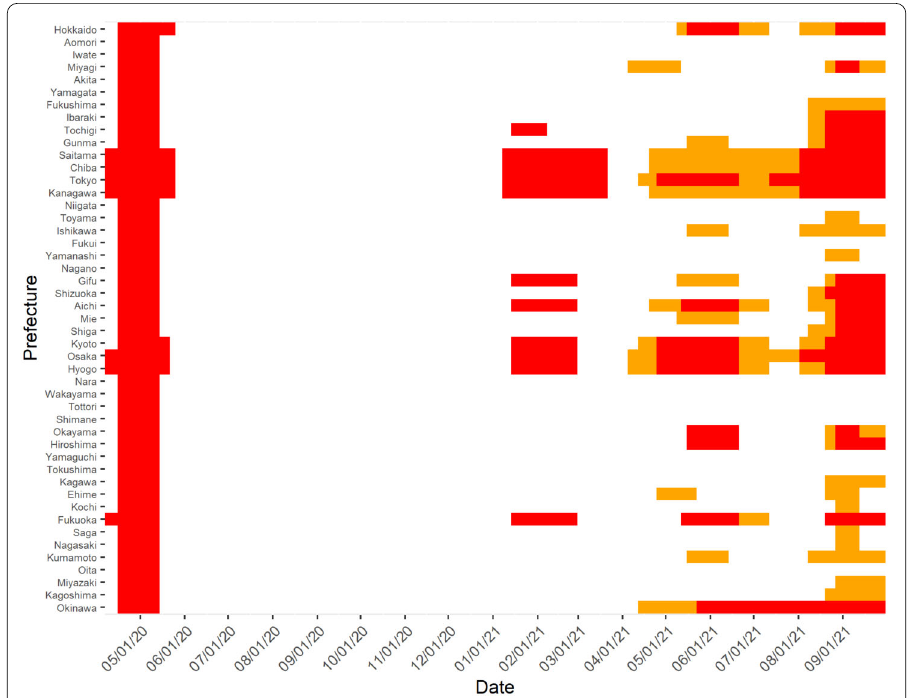
Figure 4 State of Emergency by Prefecture and Week. In this figure, a red cell indicates that the prefecture shown in the first column is in a state of emergency (SoE) in the week shown in the first row, running from the week of April 12, 2020, to that of October 3, 2021, whereas an orange cell indicates that it is in a semi-SoE. The weeks before April 12, 2020, and after October 3, 2021, are omitted because these periods had no SoE or semi-SoE. Data source: